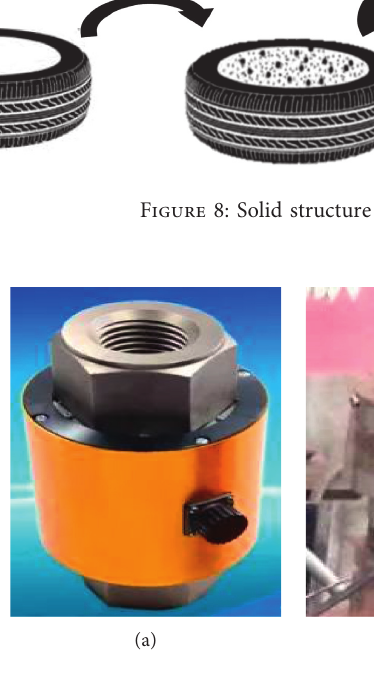
Figure 9: The load cell. (a) BLR-1/400. (b) BLR-1/600.